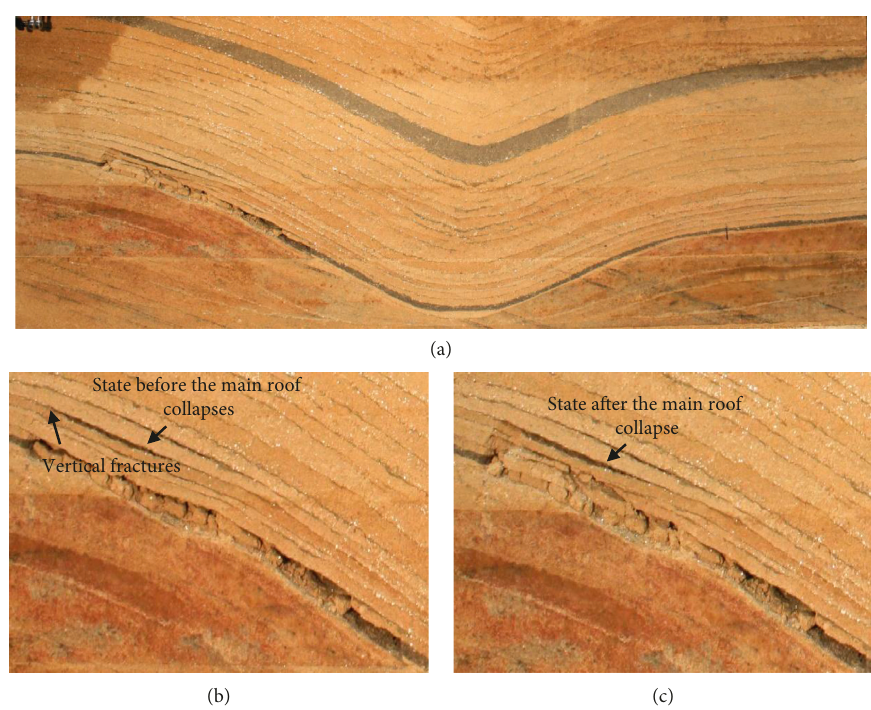
Figure 6: Periodic pressure of the main roof. (a) State after the main roof collapses. (b) Fissures and separation development. (c) The scope of the main roof collapses.